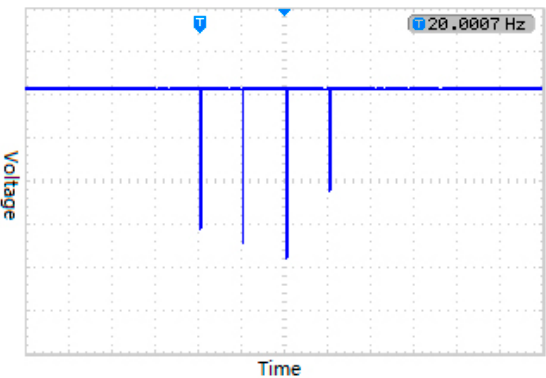
Figure 15. Waveform of 1 ms interval time.